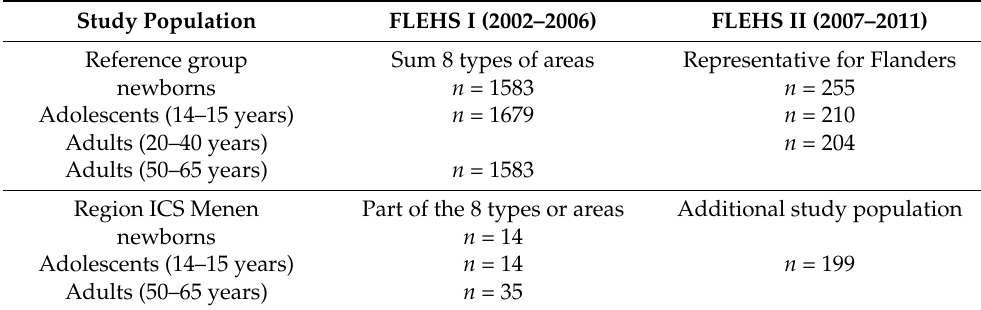
Table 1. Number of participants in each study population of FLEHS I and FLEHS II (Flemish Environment and Health Study), for the reference group as well as the region near the industrially contaminates site (ICS) in Menen. Study Population Sum 8 types of areas Representative for